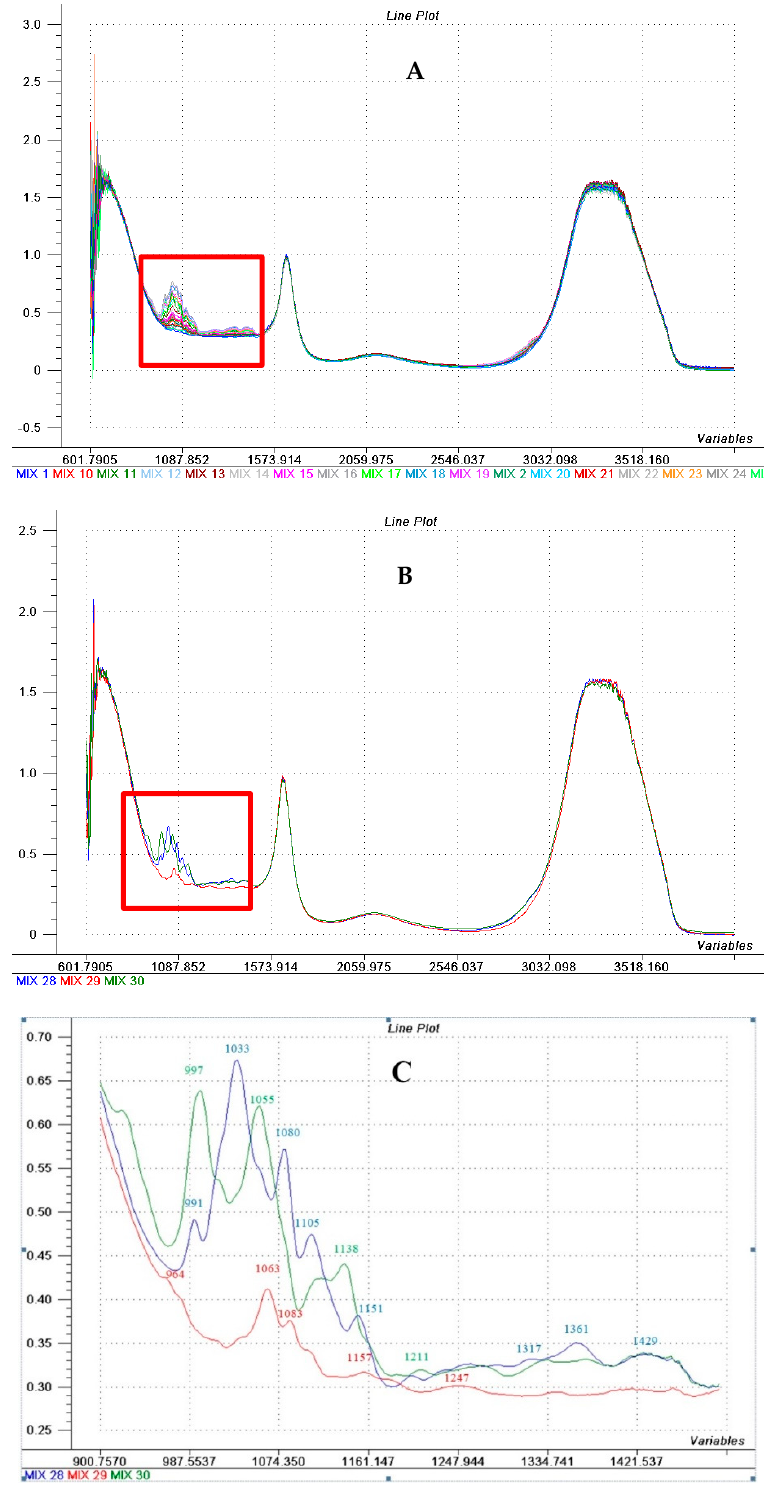
Figure 3. FT-MIR spectra of standard sugars solutions ( A ) FT-MIR spectra of the standard solutions set described on Table 2 ( B ) FT-MIR spectra of individual glucose solution (15%—blue line), fructose (5%—the red line) and sucrose (15%—green line); ( C ) Spectral area 900–1500 cm − 1 characteristic to carbohydrates for glucose individual solution (15%—blue line), fructose (5%—the red line) and sucrose (15%—green line). The X-axis—Wavenumber (cm − 1 ), the Y-axis name—Absorbance (a.u.). Alongside with the aforementioned and discussed spectra of the standard solutions of sugars, the FT ‐ MIR spectra (650–4000 cm − 1 ) of fruit juices obtained from the “Stanley”, “Vân ă t de Italia”,